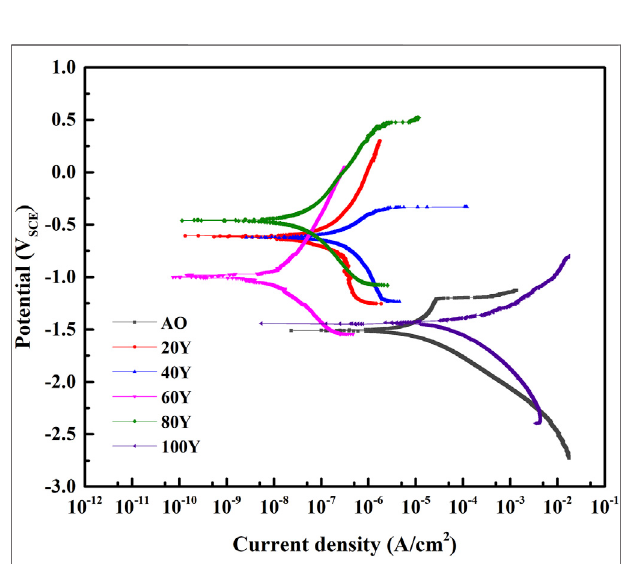
FIGURE 6 | Polarization curves of LDH specimens with different Y% fabricated on phosphoric acid anodized oxide fi lms on Mg – 2Zn – 4Y alloys of specimens immersed in 3.5 wt% NaCl solution.